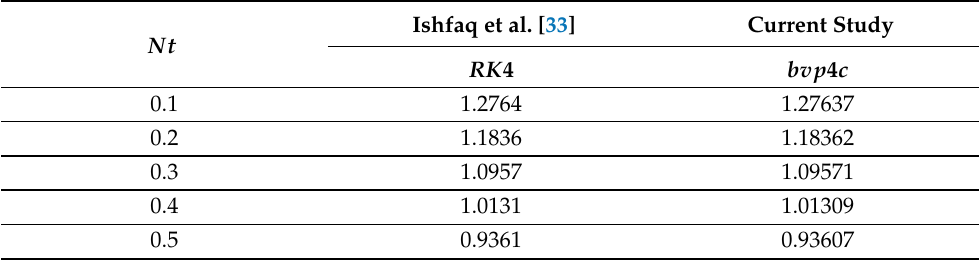
Table 1. Comparison table for values of Nusselt number, Nu for variation of thermophoresis